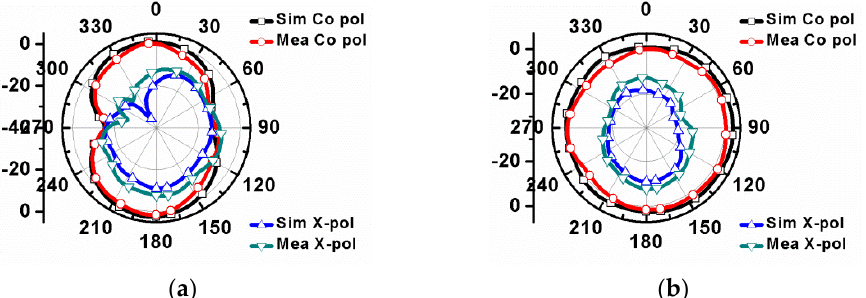
Figure 26. Patterns of the communication antenna linked with port 10 at 6 GHz in ( a ) XZ and ( b ) YZ.